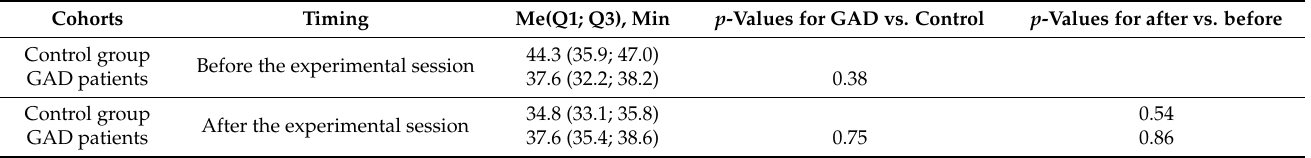
Figure 5. Average indicators of problem-solving time in anxious patients and the control group depending on the level and block; “*” denotes significant differences between the blocks of the same level in the GAD patients; RT is the reaction time. The number of correct answers did not differ between the groups of subjects, both on significantly between the groups. Table 6. Salivary antioxidant capacity in the